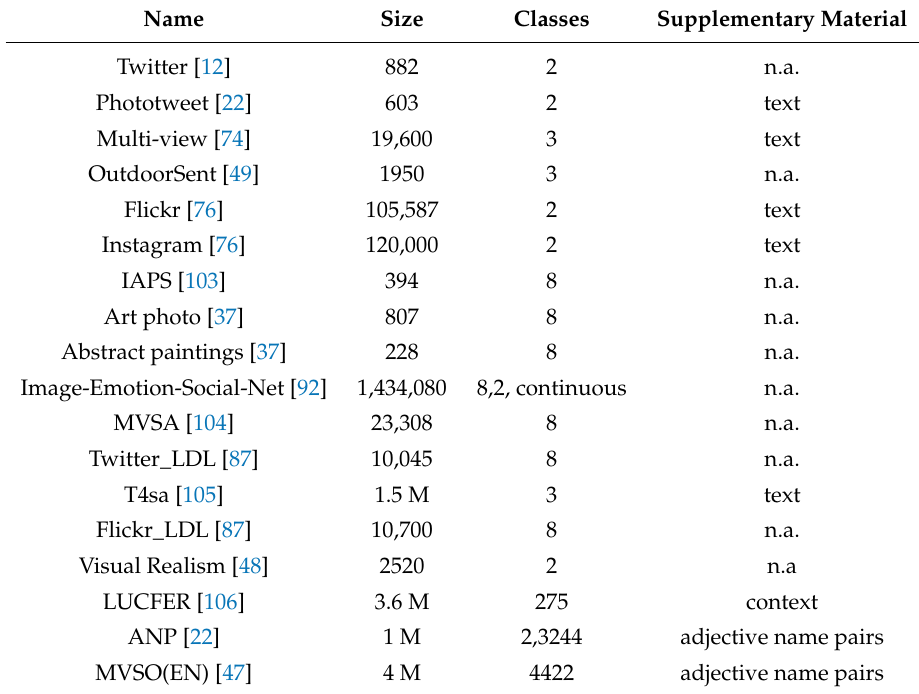
Table 3. Benchmarks for image sentiment prediction. ANP, adjective-noun pair; MVSO, multilingual visual sentiment